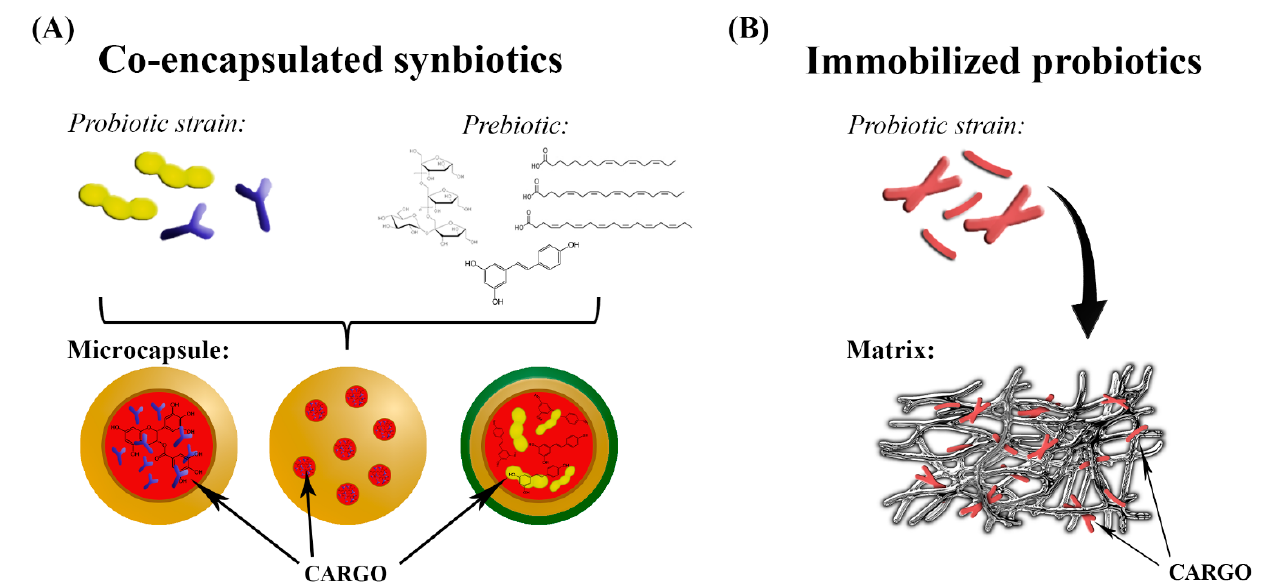
Figure 2. Schematic illustration of co-encapsulation ( A ) and immobilization ( B ) technologies.